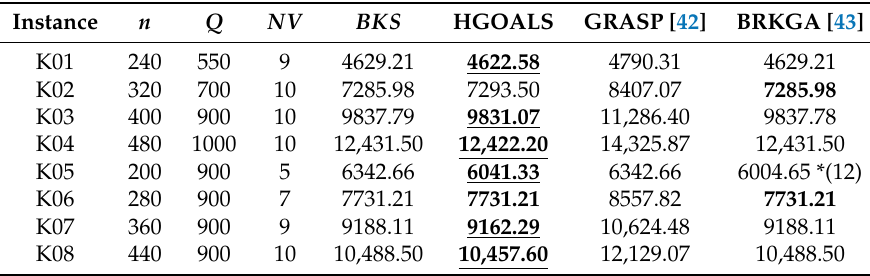
Table 5. Comparison between route decoder results and previous research for instances in group K (hierarchical objective